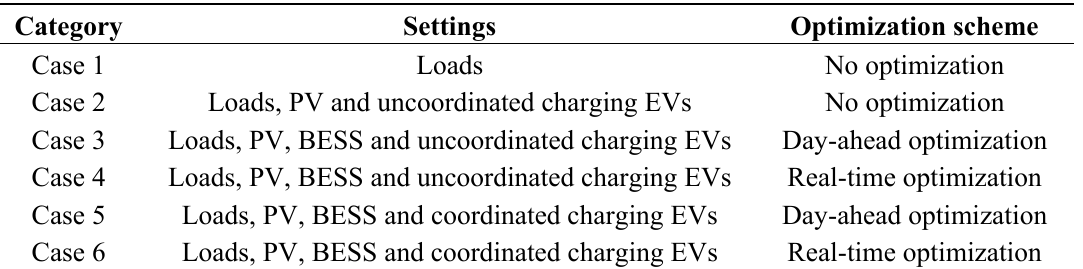
Table 1. The simulation cases’